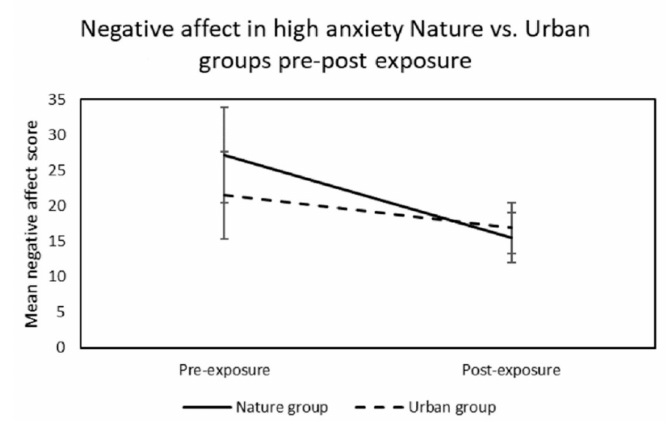
Figure 1. Line plot for mean scores of negative a ff ect pre (Time 1) and post (Time 2) intervention in high anxiety participants, stratified by nature and urban exposure group. Error bars represent a 95% confidence interval.